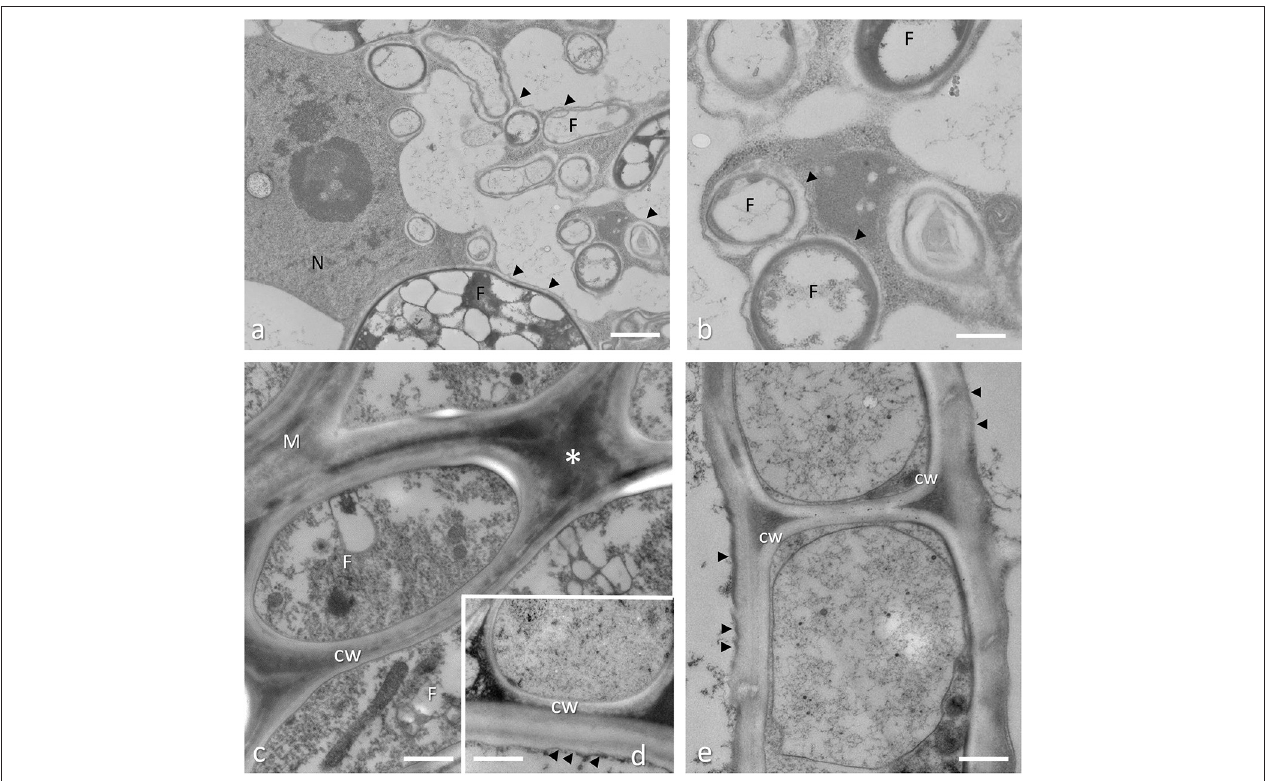
FIGURE 5 | Arbuscular mycorrhizal root conventionally fixed (a,b) and Tuber melanosporum ectomycorrhizae (c–e) , cryofixed and freeze substituted. (a) During root colonization, the AM fungus reaches the inner cortical layers where is subjected to a peculiar branching process that leads to the highly branched structures, called arbuscules, which are considered the main site for nutrient exchanges. Bar = 2.0 µ m. (b) At the electron microscope level, a new apoplastic space, based on membrane proliferation (arrowheads), is visible around the intracellular hyphae (F). Bar = 1.0 µ m. (c) During Quercus root colonization, a fungal sheath around the host root (i.e., the mantle, m) is formed by ECM fungi. This structure is formed by packed hyphae with fungal cell wall (CW) that are in contact, which surrounds the host root cells. An electron-dense material is present among the mantle hyphae (asterisk). Bar = 0.3 µ m. (d) Internal mantle, high magnification of a host-fungus contact. In ectomycorrhizal roots, the interface region between the partners is represented by the plant (arrowheads) and fungal cell walls (CW) that are in contact. Bar = 0.3 µ m. (e) Hartig net (Hn) in a fully developed hazelnut ectomycorrhiza. Hyphae develop among plant cells, and fungal cell walls (CW) are in direct contact with the plant cell walls, showing a simple interface structure (arrows). Bar = 0.3 µ